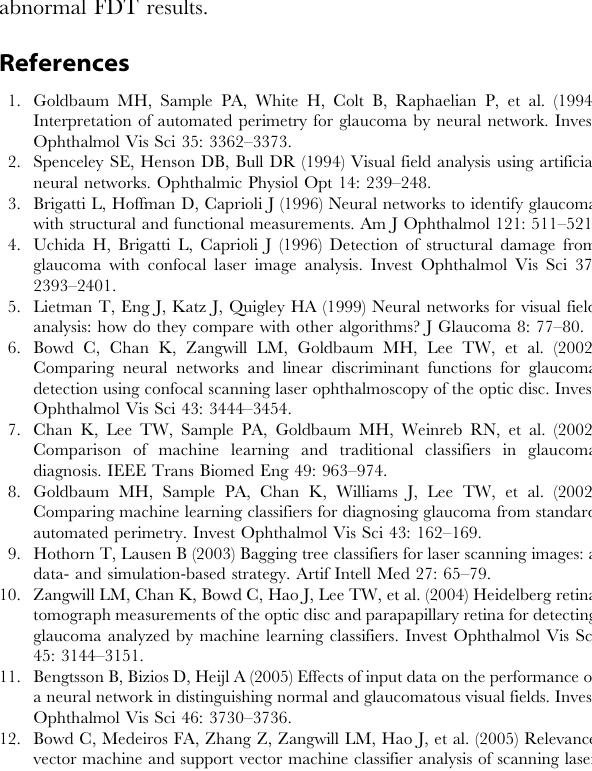
Figure 5. Color-coded displays simulating total deviation plots along with age at 2 2 and + 2 standard deviations of each axis from the centroid of normal Cluster N , that was composed entirely of abnormal FDT fields. Axis 1 appears to represent diffuse moderate visual field loss. Axis 2 and Axis 3 appear to represent more severe superior nasal and inferior nasal defects, respectively. Axis 4 appears to represent combined superior and inferior nasal step defects, and Axis5 appears to represent a diffuse pattern of loss, primarily localized